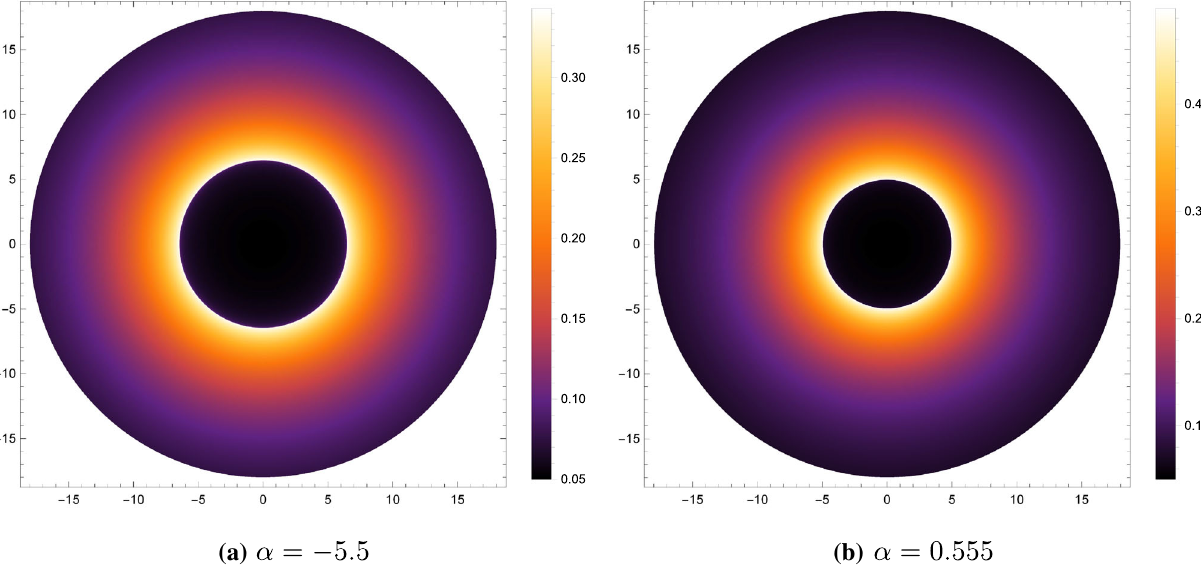
Fig. 6 The shadow of the black hole cast by the infalling accretion for different α with M = 1 in the ( x , y ) plane. The brightest ring outside the black hole is the photon